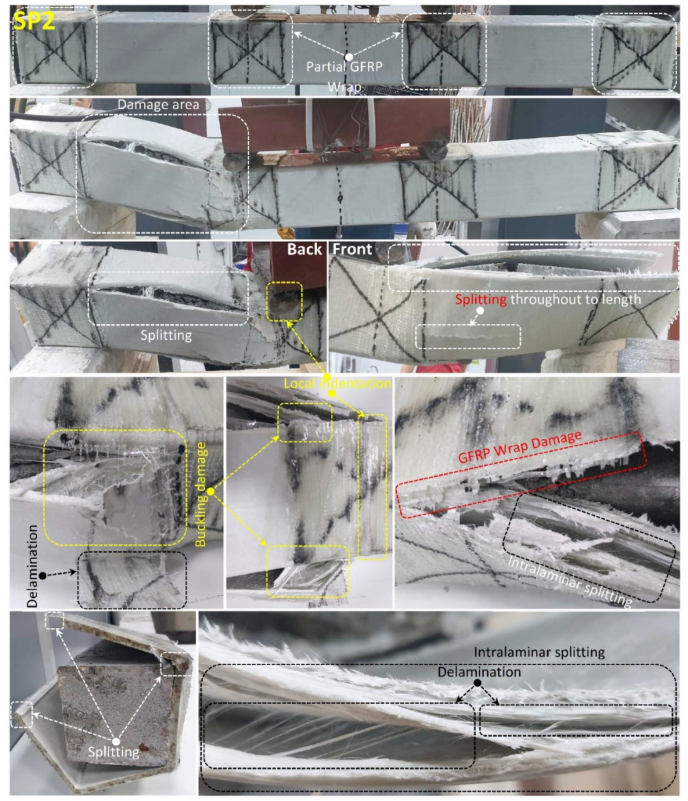
Figure 11. Undamaged and damaged specimen images of